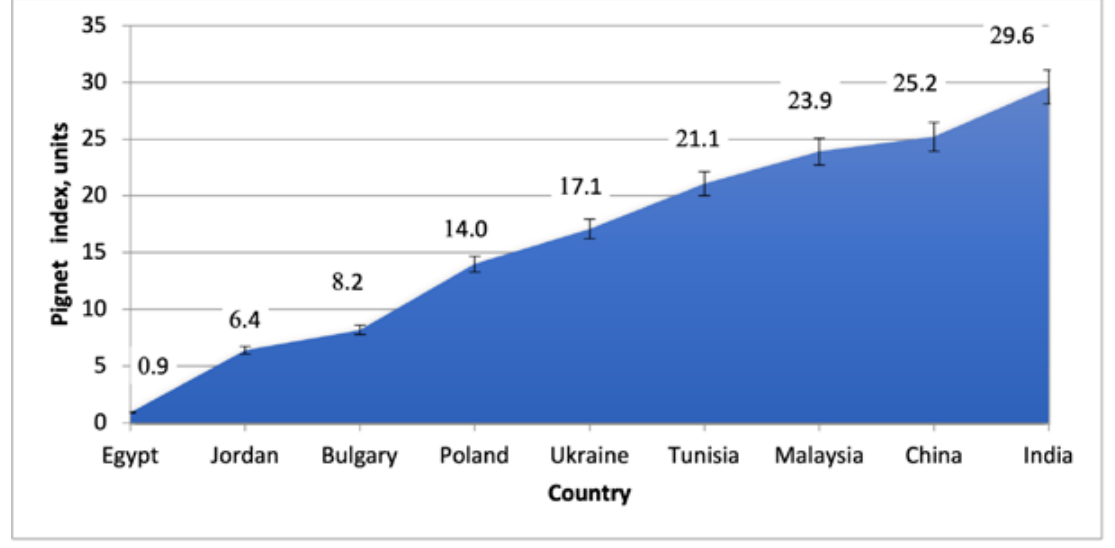
Figure 2. Pignet value of student index, units